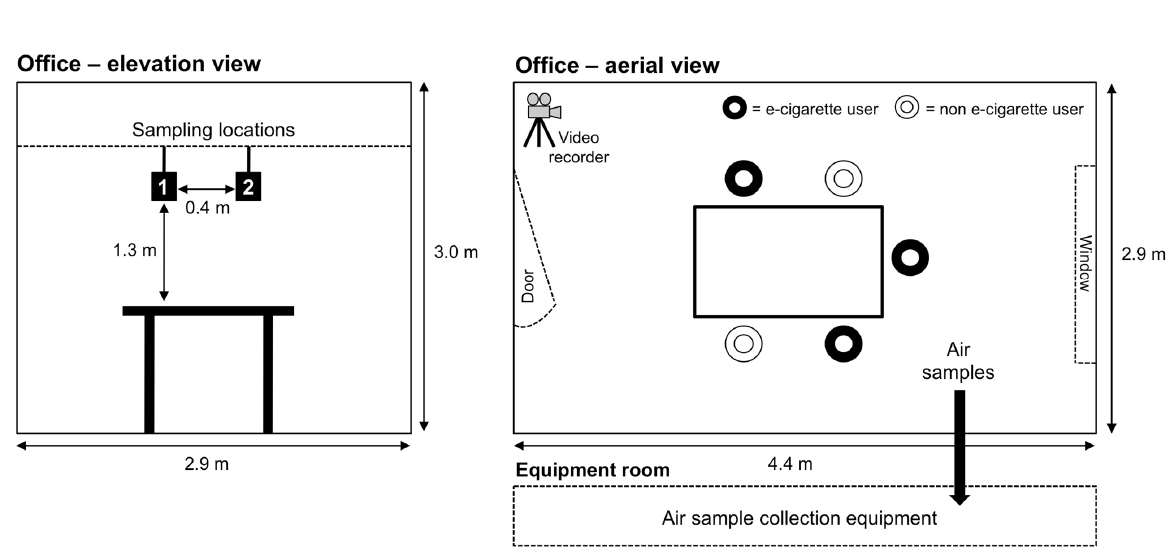
Figure 1. The layout of the meeting room used in this study (not drawn to scale). Sampling locations and positions of the e-cigarette users and non-users during the meeting are highlighted.